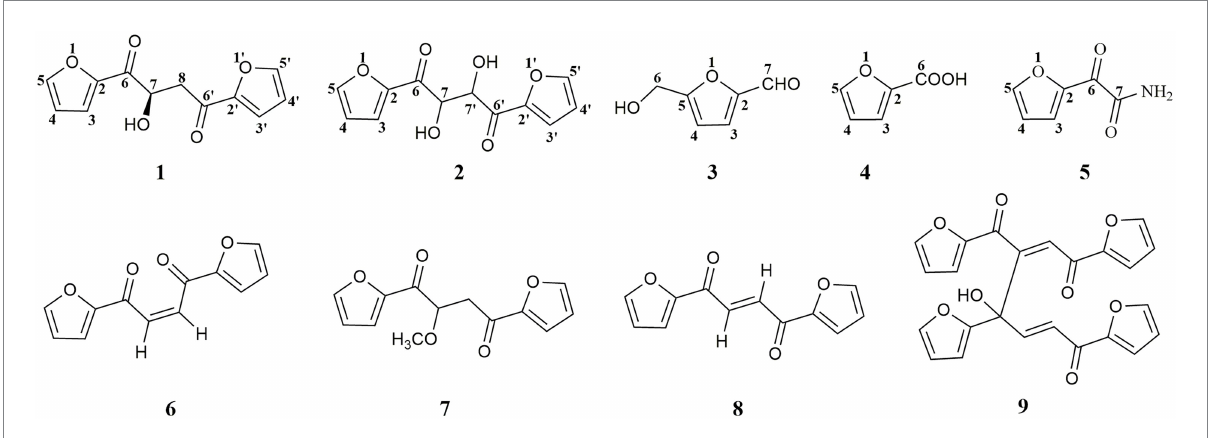
FIGURE 1 The structures of the compounds 1 –